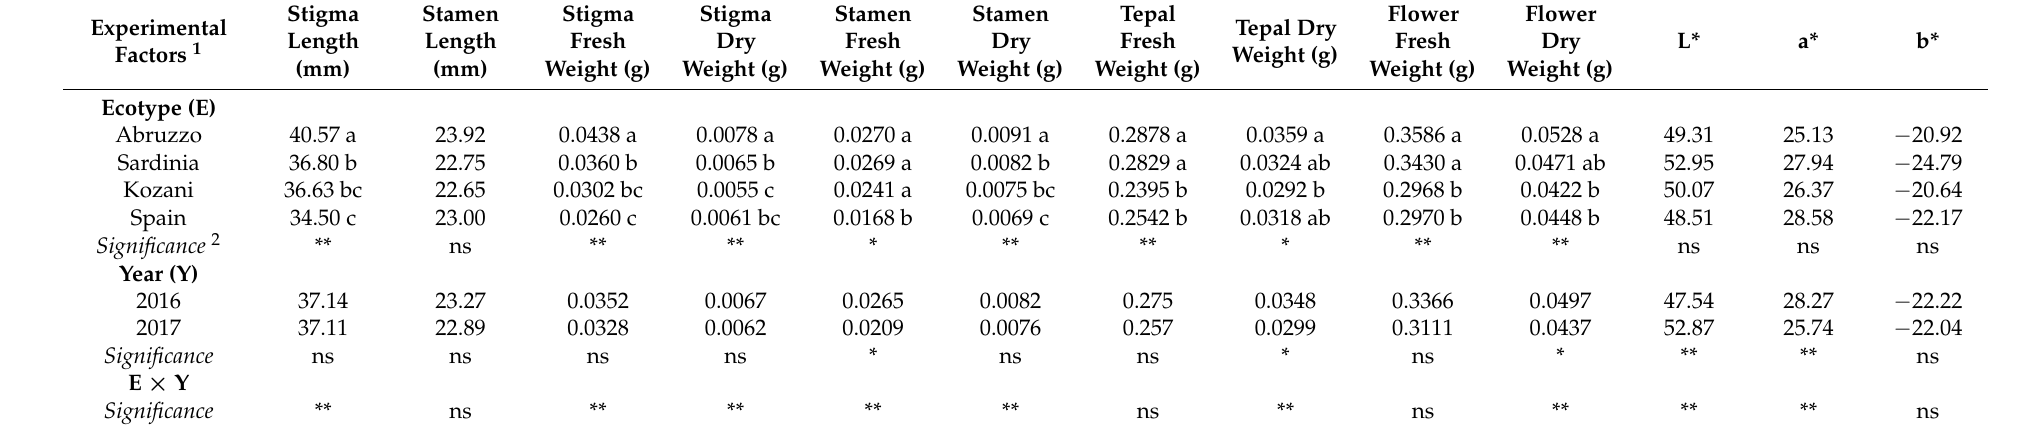
Table 3. Flower morphological and colorimetric traits related to ecotype (E), year (Y) and their